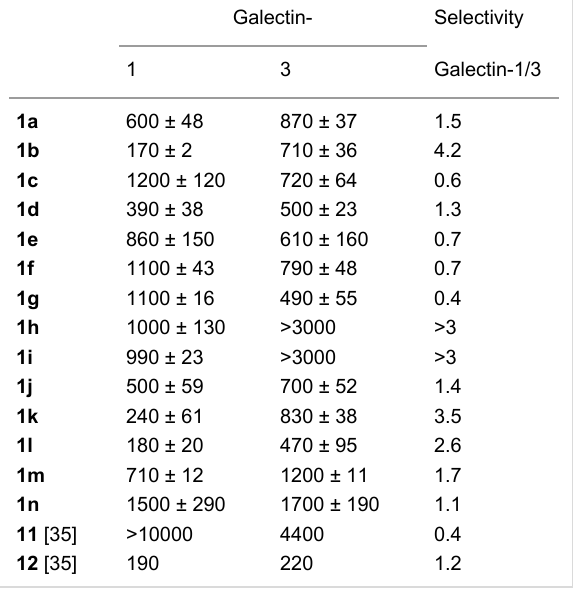
Table 1: Dissociation constants ( K D ± SEM in µM) and selectivities of 1a – n and references methyl β -D-galactopyranoside ( 11 ) and methyl β -lactoside ( 12 ) binding to galectin-1 and -3 determined in a competi- tive fluorescence polarization assay [33]. Galectin-